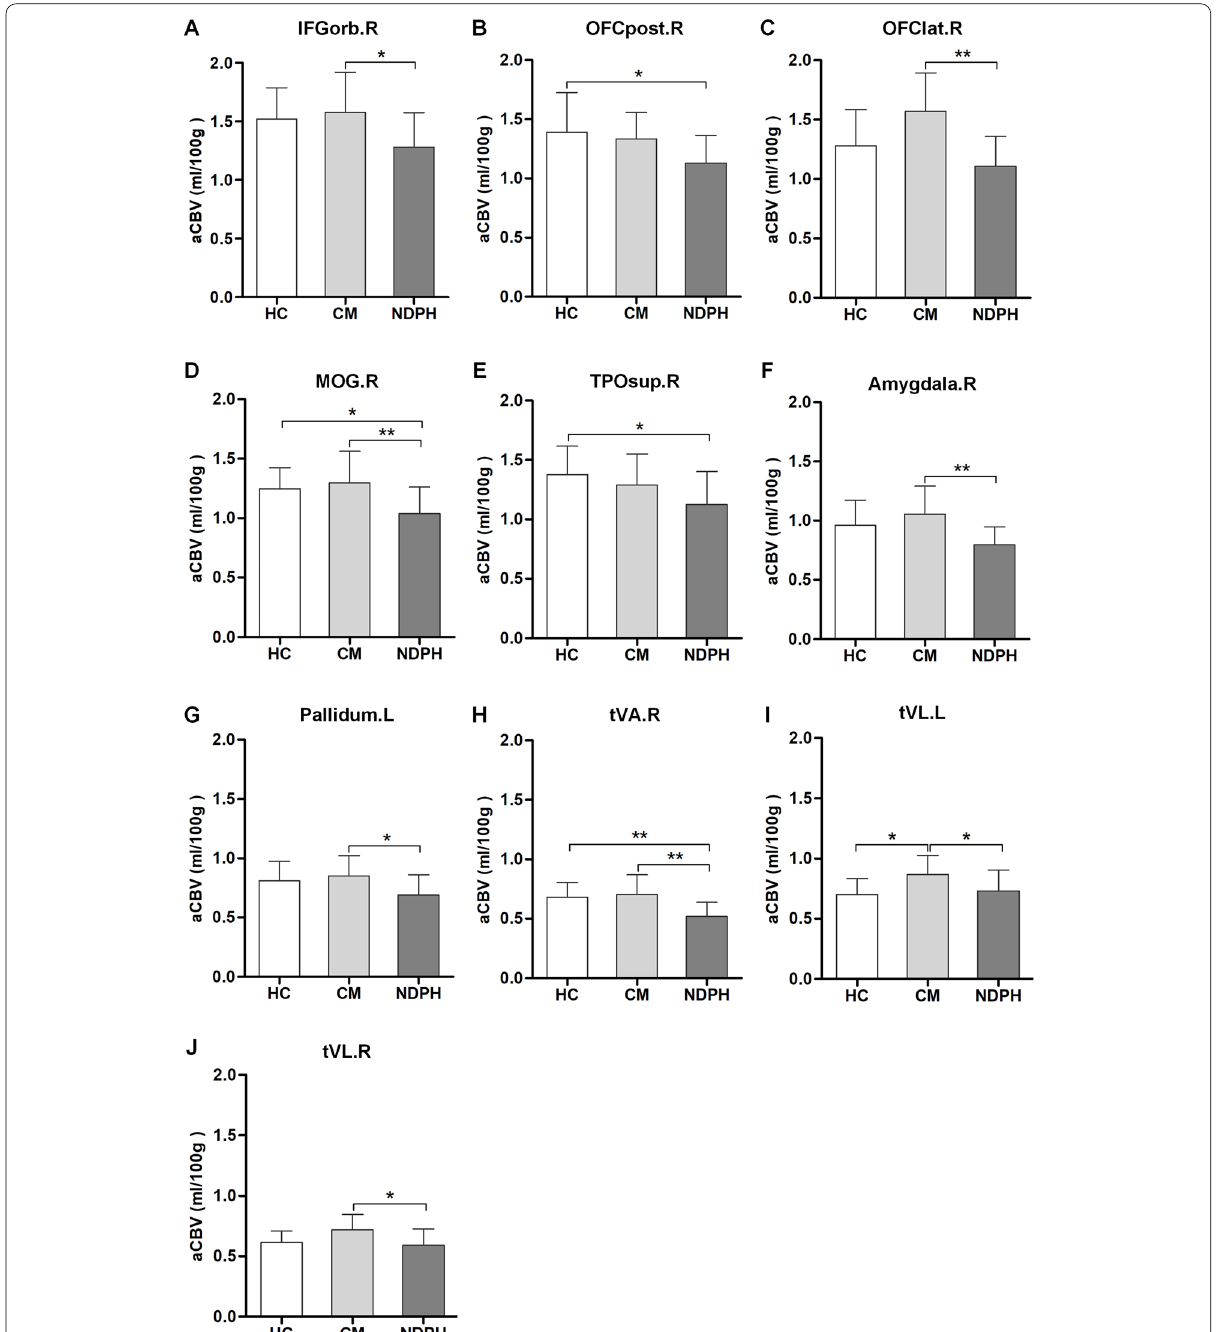
Fig. 3 Brain regions with significant differences in the aCBV between NDPH and HC groups, NDPH and CM groups, as well as CM and HC groups ( A-J ). HC healthy control, NDPH new daily persistent headache, CM chronic migraine. IFGorb.R right inferior frontal gyrus pars orbitalis, OFCpost.R right posterior orbital gyrus, OFClat.R right lateral orbital gyrus, TPOsup.R right superior temporal gyrus, temporal pole, MOG.R right middle occipital gyrus, Amygdala.R right amygdala, Pallidum.L left pallidum, tVA.R right thalamus, ventral anterior nucleus, tVL.L left thalamus, ventral lateral nucleus, tVL.R right thalamus, ventral lateral nucleus. * P <0.05, ** P